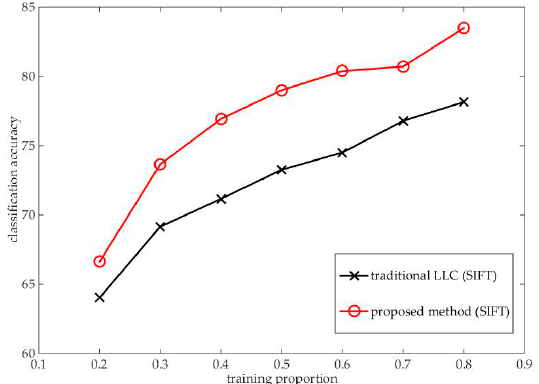
Figure 7. Different ratios of training set experiments based on SIFT.